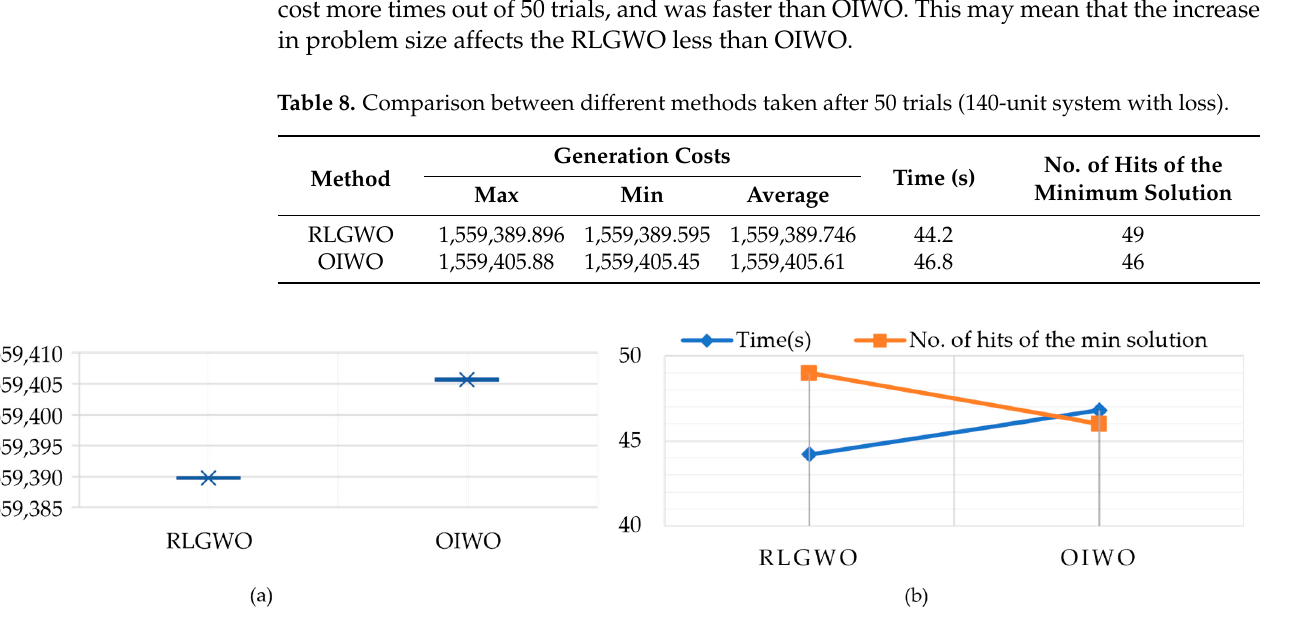
Figure 10. Comparative convergence characteristic of original GWO and proposed RLGWO algorithm for the 140-unit system.